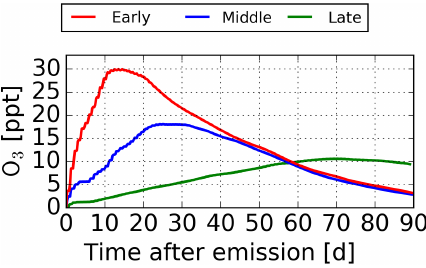
Figure 3. “Typical” temporal development of an early (red), a mid- dle (blue) and a late (green) O 3